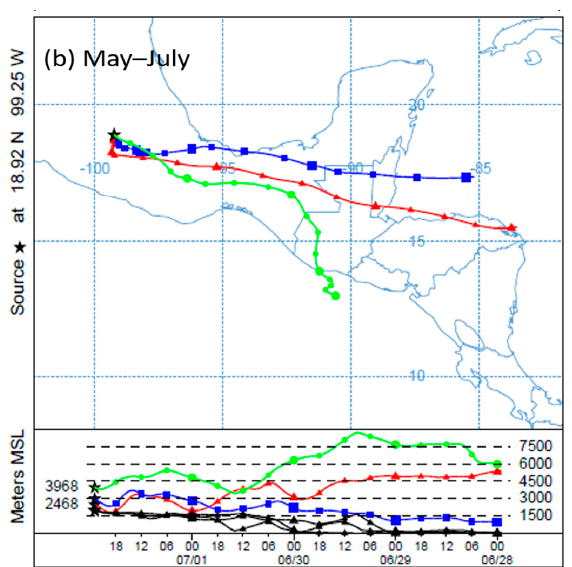
Figure 2. Behavior of wind trajectories in Cuernavaca during February and July 2016: ( a ) the trend observed between February and April (west–southwest); ( b ) the trend observed between May and July (east–southeast). Source: 18°55 ′ N, 99°13 ′ W, heights: 500, 1000 and 2000 m above mean sea level (a.m.s.l.).